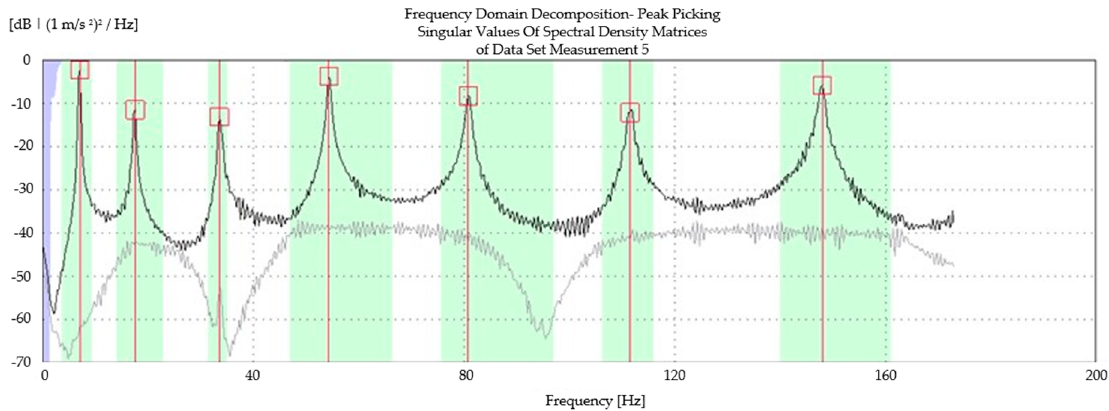
Figure 10. Characteristic record of frequency domain decomposition (FDD) for the determination of natural frequencies on reference iron tie rod 6B ‒ C.